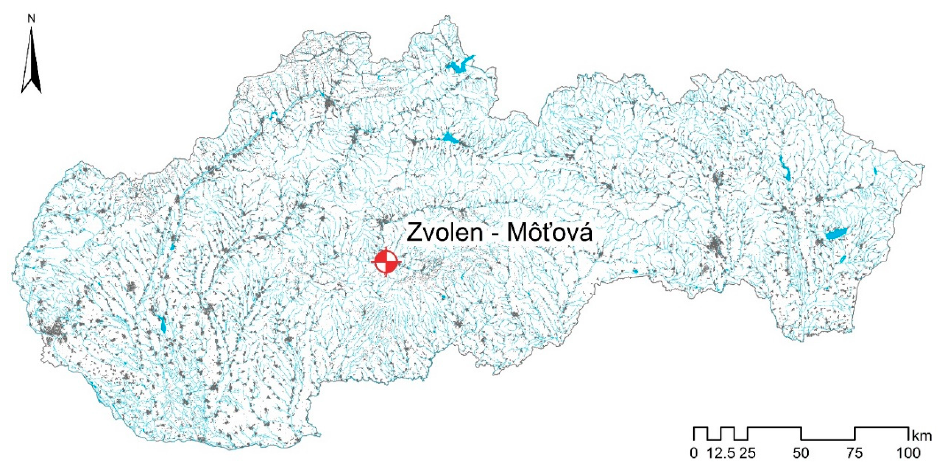
Figure 1. Study area in the map of Slovakia.